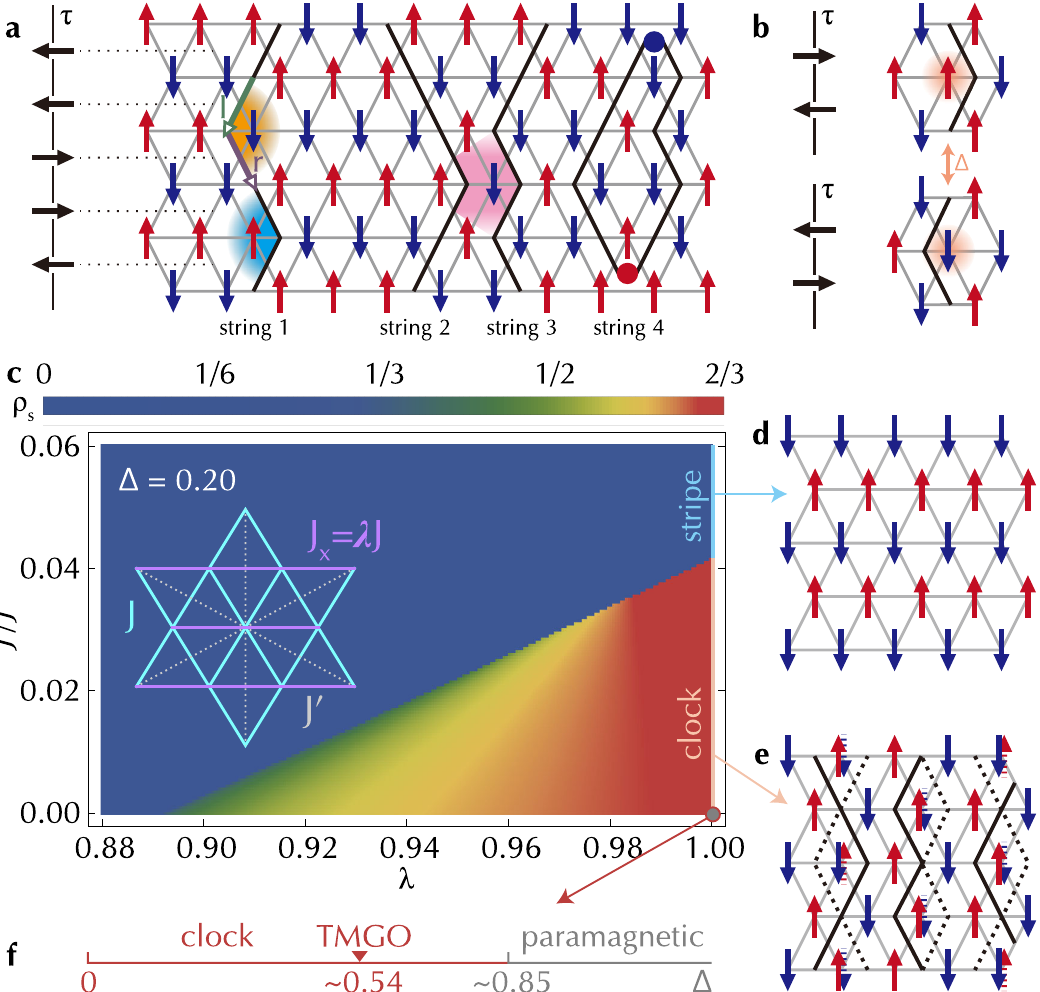
Fig. 2 An illustration of the emergent strings in frustrated TFIM. a An example of string mapping of a spin con fi guration. Strings 1, 2 and 3 don ’ t involve triangle-rule-breaking con fi gurations and are thus directional. The l and r vectors on string 1 denote the two directions of the segments. The spin chain labelled τ on the left illustrates the effective spin-1/2 con fi guration mapped from string 1. The orange and cyan shaded angles on string 1 denote a kink-antikink pair. The pink shaded area illustrates that two nearby strings induce repulsion. String 4 is a closed non-topological string connecting two spinons denoted by red and blue points. b The elementary fl ipping process brought by the transverse fi eld j lr i $ j rl i . The transverse fi eld acts upon the shaded spin. c The ground state string density as a function of anisotropy λ and NNN coupling J ′ , obtained from large scale QMC simulation. Inset: an illustration of the lattice setup. d , e Con fi guration and string correspondence of two speci fi c phases: stripe phase ( d ) with average string density h ρ s i ¼ 0 and clock phase ( e ) with h ρ s i ¼ 2 = 3 . The collapsed arrows denote the superposition of spin-up and down. Correspondingly, the strings are superpositions of con fi gurations denoted by the solid and dashed lines. f The phase diagram at λ = 1 and J ′ = 0, at different transverse fi eld Δ